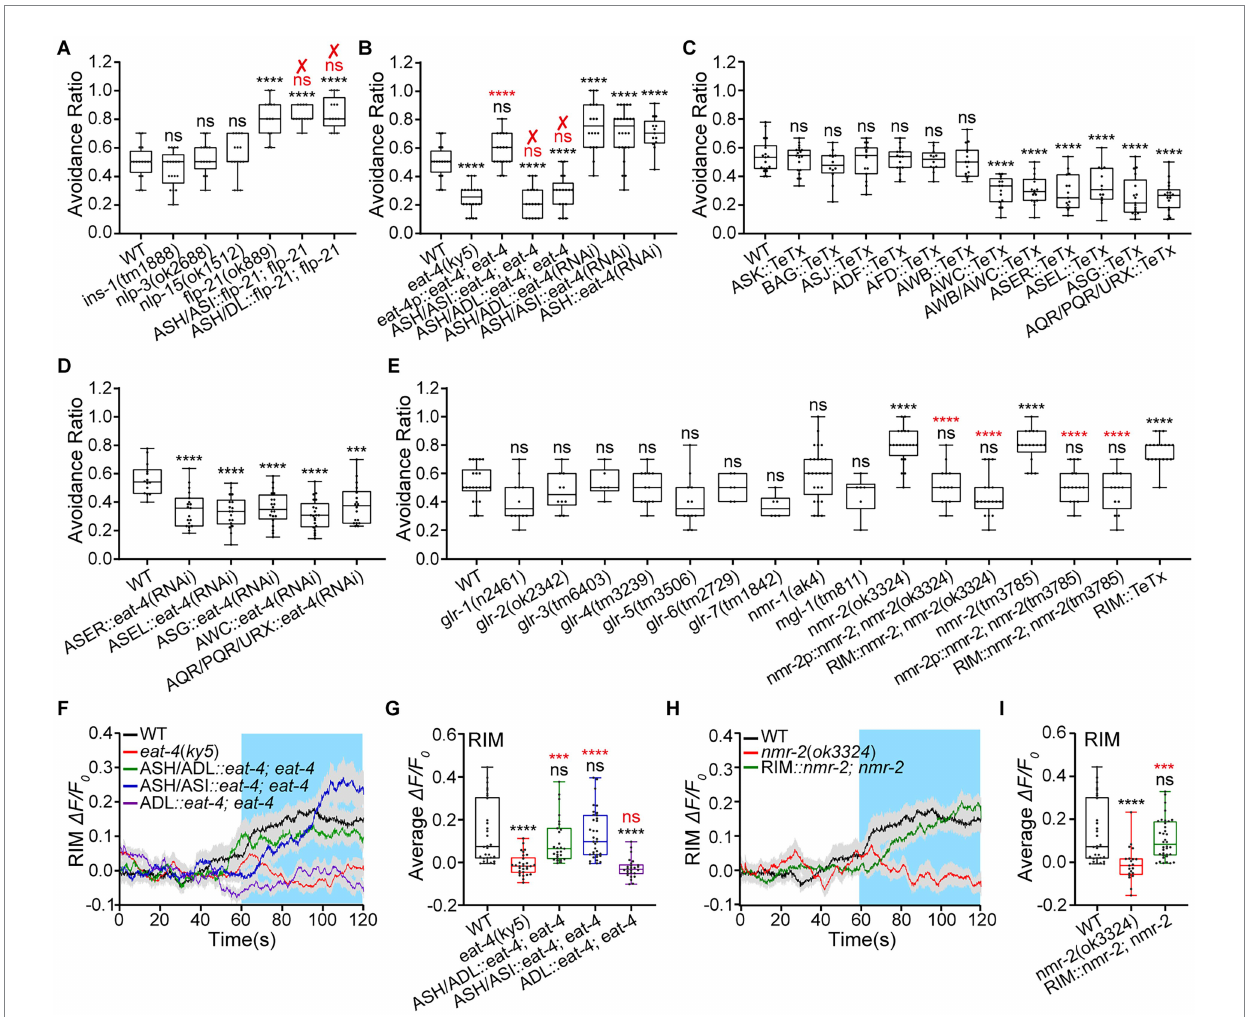
FIGURE 3 RIM suppresses animal hyperosmotic avoidance, and ASH inhibits RIM activities via the glutamate/NMR-2 signaling pathway. (A–E) Ratio of avoidance of a droplet of the 0.88 Osm glycerol/M13 hyperosmotic solution in animals of indicated genotypes. “ ✘ ” indicates a failure to restore WT behavior and the genetic rescue. (F–I) The somal calcium transients in RIM interneurons in response to the hyperosmolality in the WT N2, mutant, and transgenic animals of indicated genotypes. (F,H) Curves of Ca 2+ transients presented as means (solid traces) ± SEM (gray shading) with cerulean background indicating the application of 0.88 Osm glycerol/M13 solution; G and I, box plots of the average intensity of Ca 2+ signals during stimulation with each dot representing the data from each tested worm. Heat maps of Ca 2+ signals are shown in Supplementary Figure S3. Statistical significance is indicated as and in different colors: ns, not significant, *** p < 0.001, and **** p < 0.0001 in different colors; black, the tested vs. the WT; red, the gene rescued vs. the related